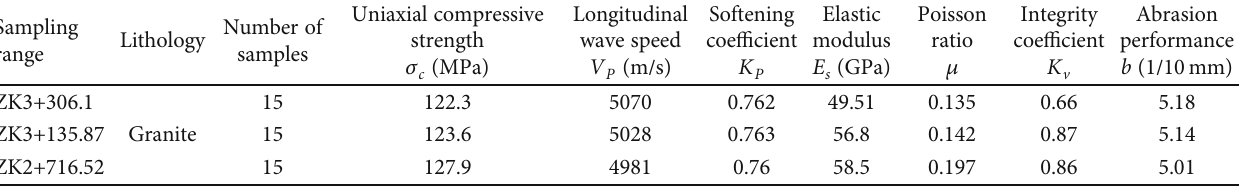
Table 2: Granite mechanical test